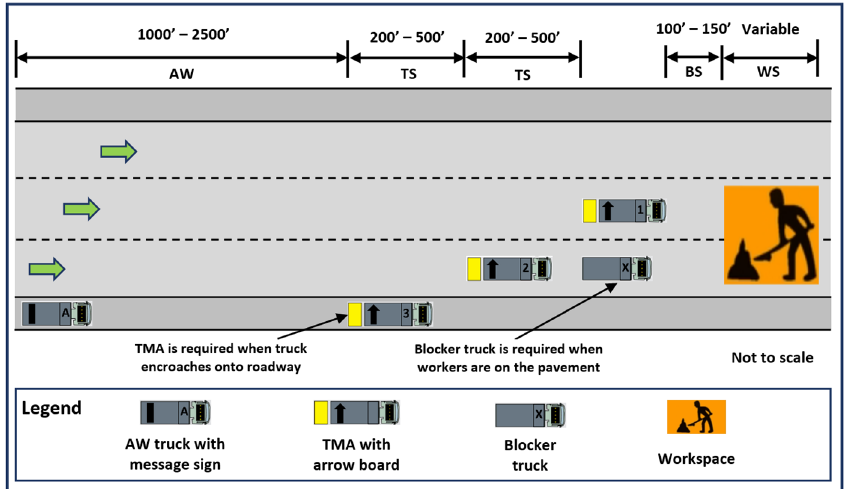
Figure 4. Recommended minimum requirements to perform work in the center lane or along a skip dash when three or more traffic lanes per direction are present [14].